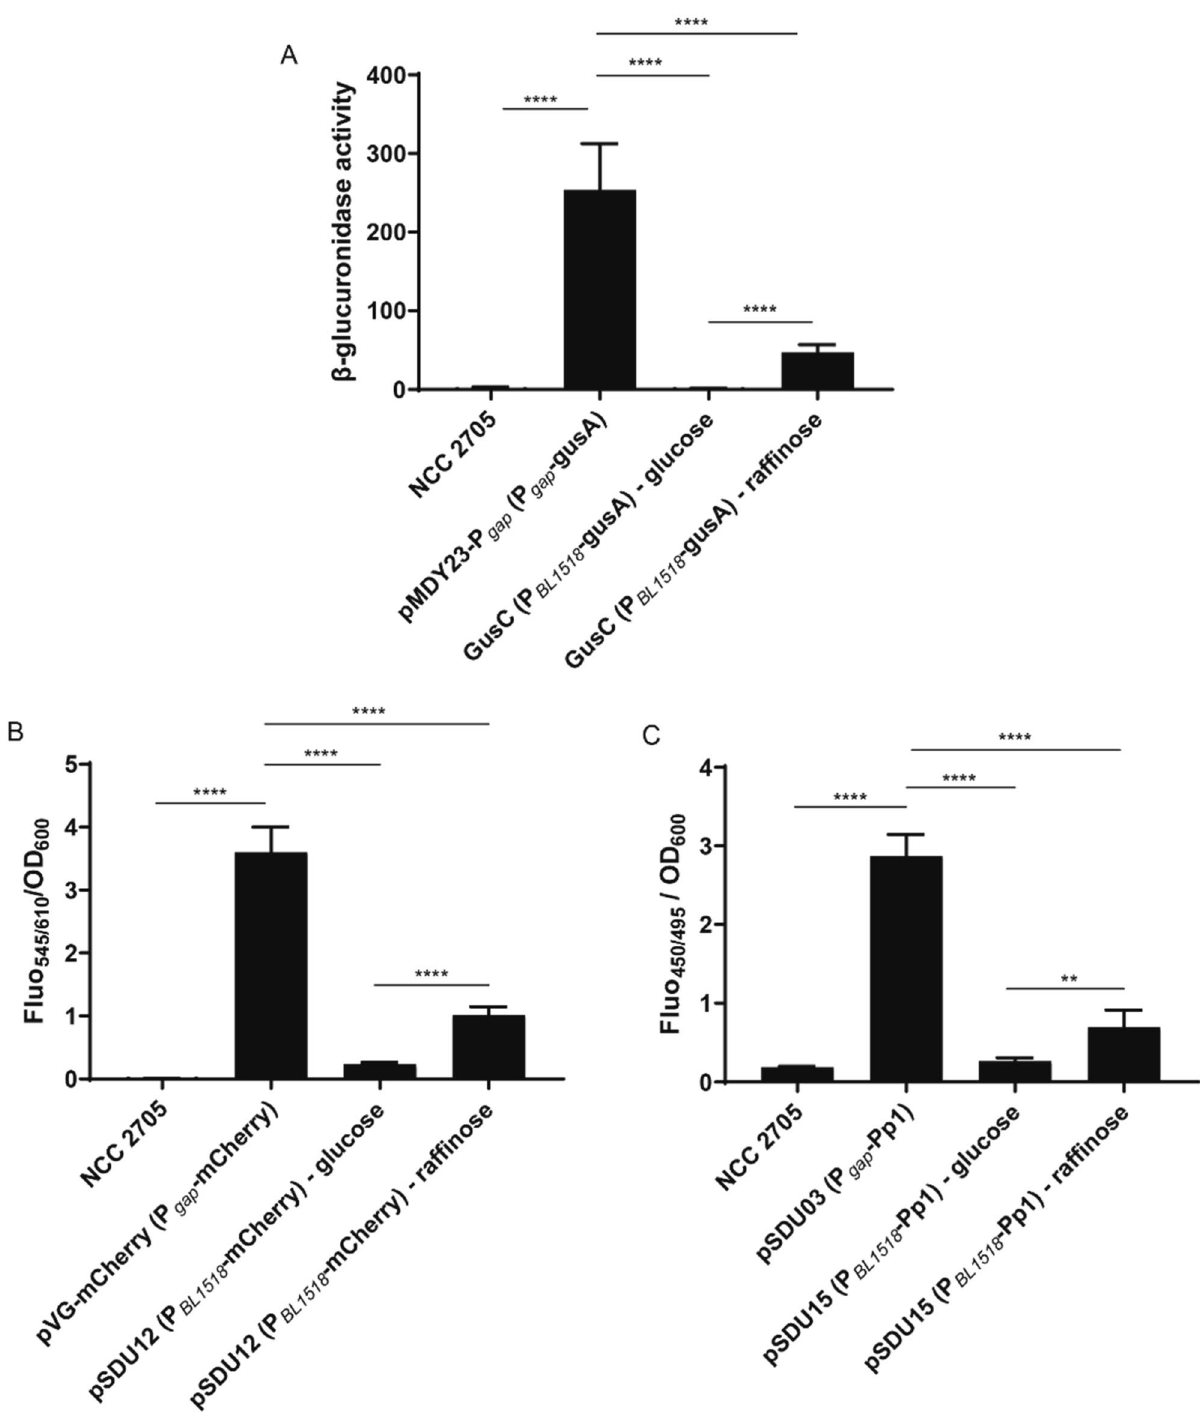
Figure 1. B. longum NCC 2705 promoter activities measured using different reporter systems in mid- exponentially grown cells. Background activity/fluorescence of the wildtype and recombinant strains harboring reporter genes under the control of P gap (grown on glucose) or P BL1518 (grown on glucose or raffinose) was measured through β-glucoronidase ( A ), fluorescence emitted by mCherry ( B ) and fluorescence emitted by the anaerobic cyan-blue Pp1 ( C ). Values represent average of biological triplicates. Significant differences were calculated using one-way ANOVA, followed by a Sidak’s multiple comparison test (** P -value < 0.01; **** P -value <